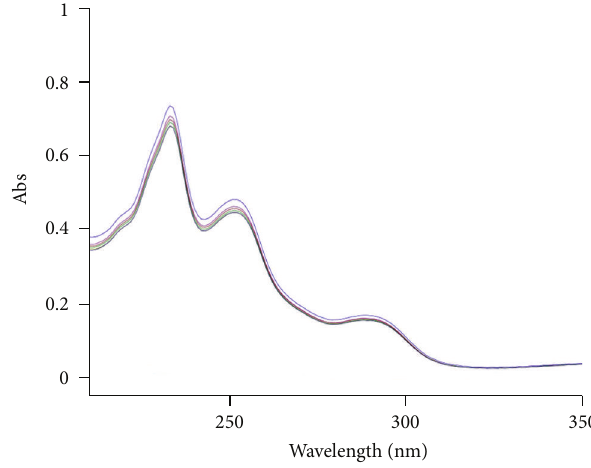
Figure 4: UV spectra of unirradiated and gamma irradiated epidoxorubicin.